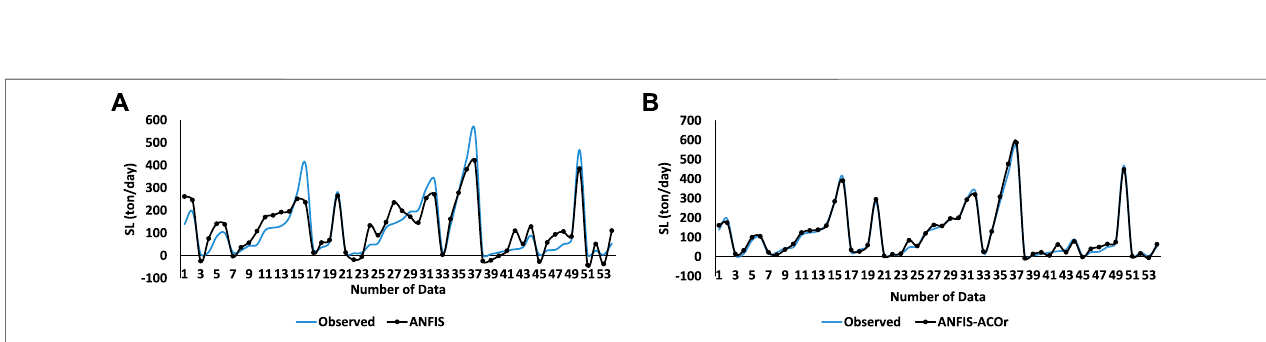
FIGURE9| ResultsforANFISandANFIS-ACOrinallinputs. (A) ComparingtheSLobservedwiththeSLpredictedinANFISinthetestmode, (B) ComparingtheSL observed with the SL predicted in the ANFIS-ACOr in the test mode.